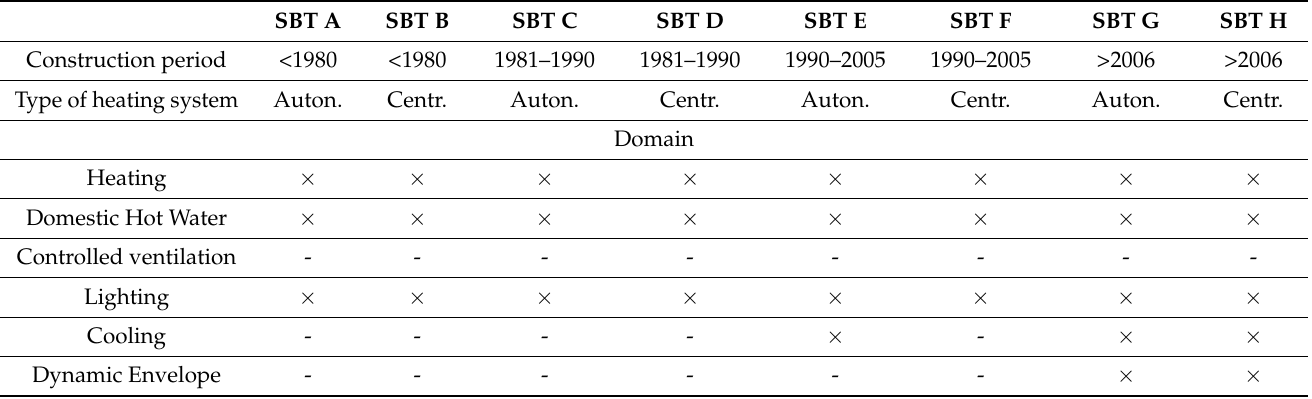
Table 2. Domains of the smart building typologies